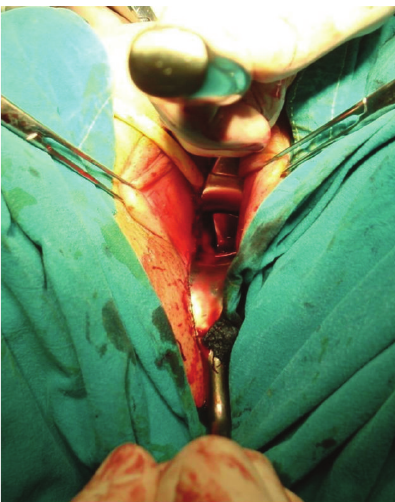
Figure 9: Anastomosis of the sigmoid colon with genital skin flaps, deeply hidden.